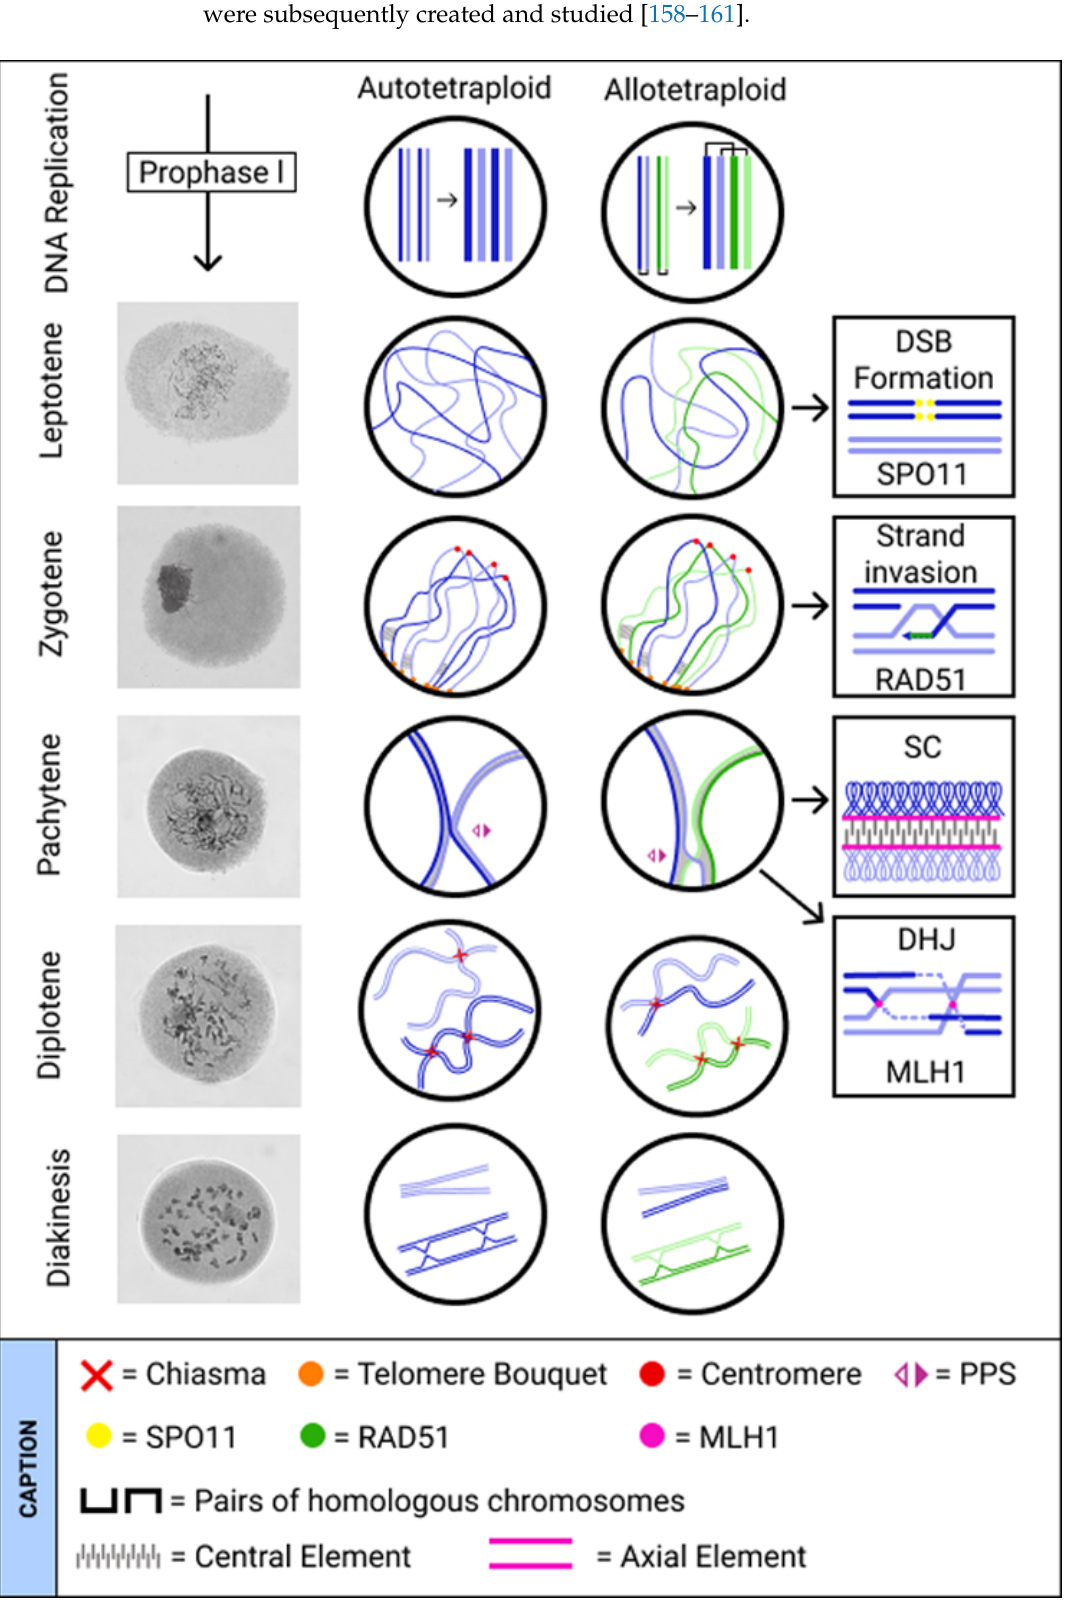
Figure 1. Pre-meiotic and early meiotic events in auto- and allotetraploid species illustrating regular meiotic behavior during Prophase I. Meiosis is preceded by one round of DNA replication during which sister chromatids are duplicated. During leptotene, genetic recombination is initiated, and double-strand breaks (DSBs) are catalyzed by the protein Spo11 and repaired through homologous recombination. This process leads to DSB invasion into the non-sister chromatid by the RAD51 protein, initiating physical interactions and driving chromosome sorting [26–28]. Homologous recognition may be facilitated by the clustering of telomeres at one pole of the cell, forming the telomere bouquet [38]. During zygotene,